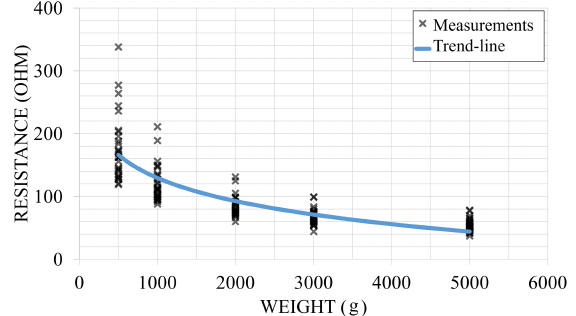
Figure 1. Fabric sensor